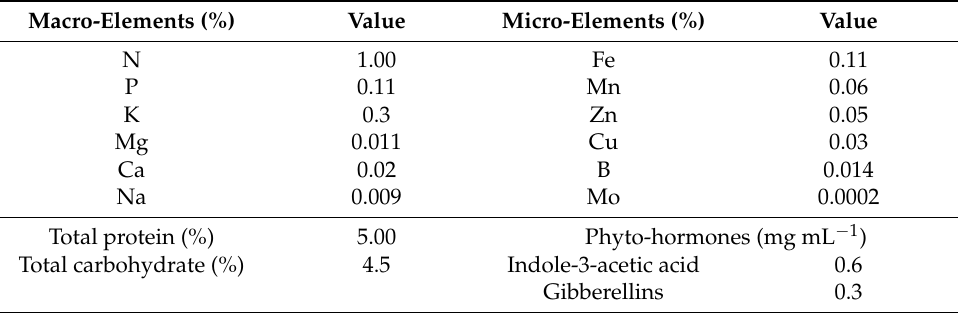
Table 1. Constituents of prepared yeast stock solution.